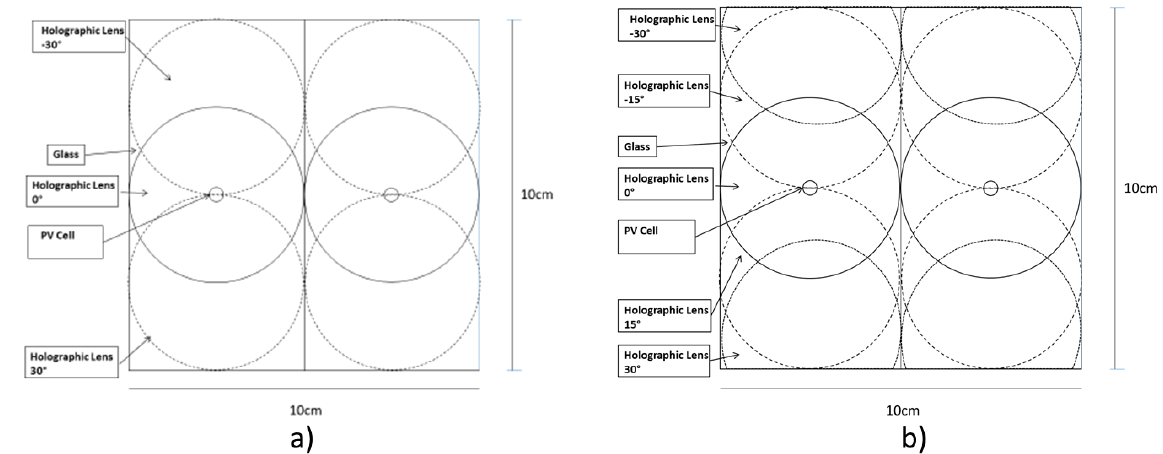
Figure 12. Angular multiplex lenses at ( a ) three angles: 0 ◦ and ± 30 ◦ and ( b ) five angles: 0 ◦ , ± 15 ◦ , and ± 30 ◦ .